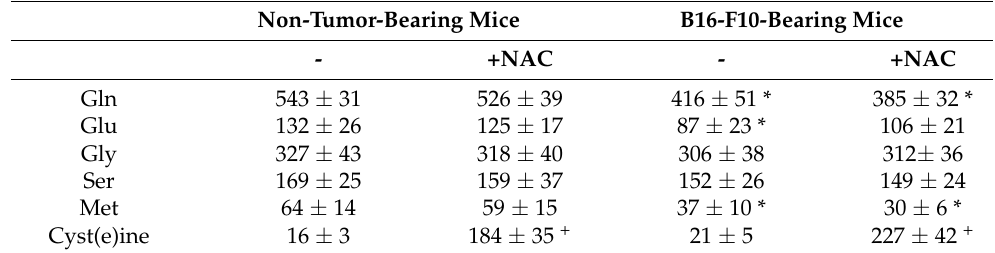
Table 1. Effect of NAC on the plasma levels of amino acid precursors for GSH synthesis in mice bearing B16-F10 xenografts ( A ), and on the GGT activity and cyst(e)ine uptake in B16-F10 melanoma cells isolated from growing xenografts ( B ). NAC (240 mg/kg) was administered orally to mice bearing B16-F10 xenografts starting 5 days after tumor inoculation. All measurements were performed in plasma or cells isolated 15 days after tumor inoculation. * Significantly different p < 0.05, comparing plasma levels of amino acids in B16-F10-bearing mice versus non-tumor-bearing mice (n = 5–6) (A); + Significantly different p < 0.01, comparing data obtained in metastatic cells isolated from mice treated NAC versus controls treated with vehicle (B) (n = 6). A Amino Acid Concentration ( µ M) in Plasma Non-Tumor-Bearing Mice B16-F10-Bearing Mice - +NAC - +NAC Gln 543 ± 31 526 ± 39 416 ± 51 * 385 ± 32 * Glu